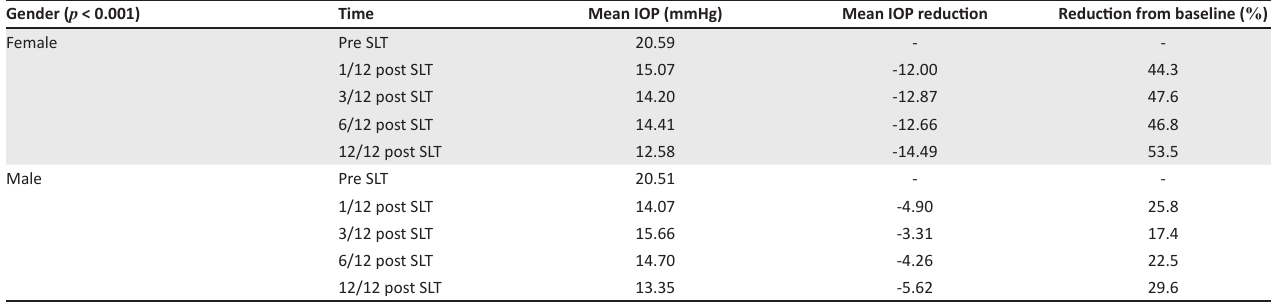
IOP, intraocular pressure; SLT, selective laser trabeculoplasty. TABLE 6: The role of ethnicity in the outcome of selective laser trabeculoplasty. Ethnicity ( p <